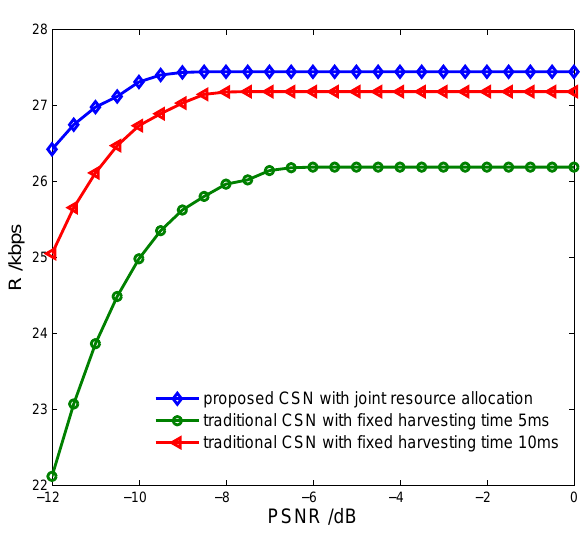
Figure 17. Transmission rate vs. cognitive sensor network model with fixed harvesting time.